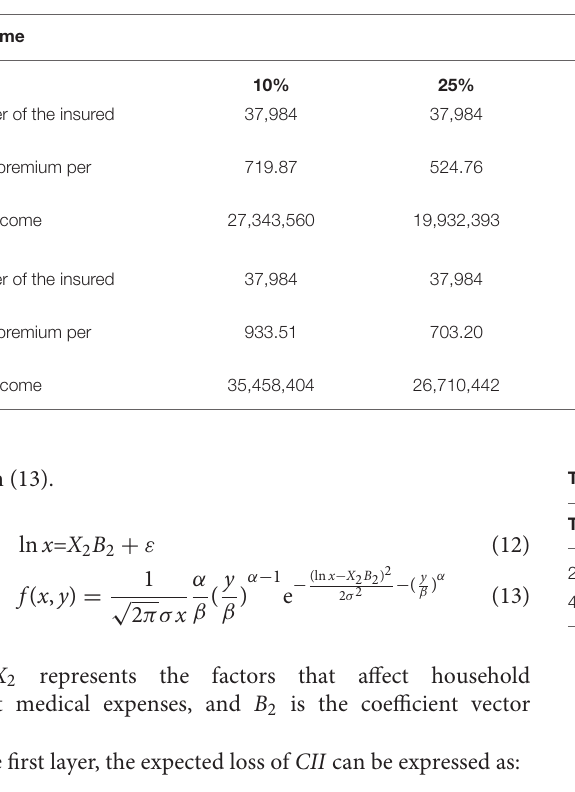
TABLE 7 | The fund balance of the CII in the basic approach.